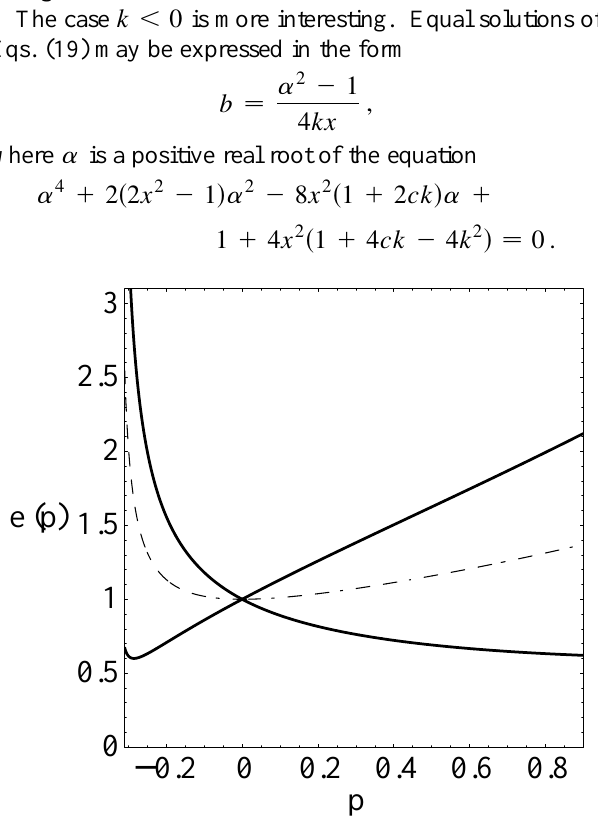
FIG. 3. Equilibrium radiation emittance as a function of the insertion lens. Either sign of the slope may appear depending on the arc lattice. The dashed line corresponds to the result obtained in